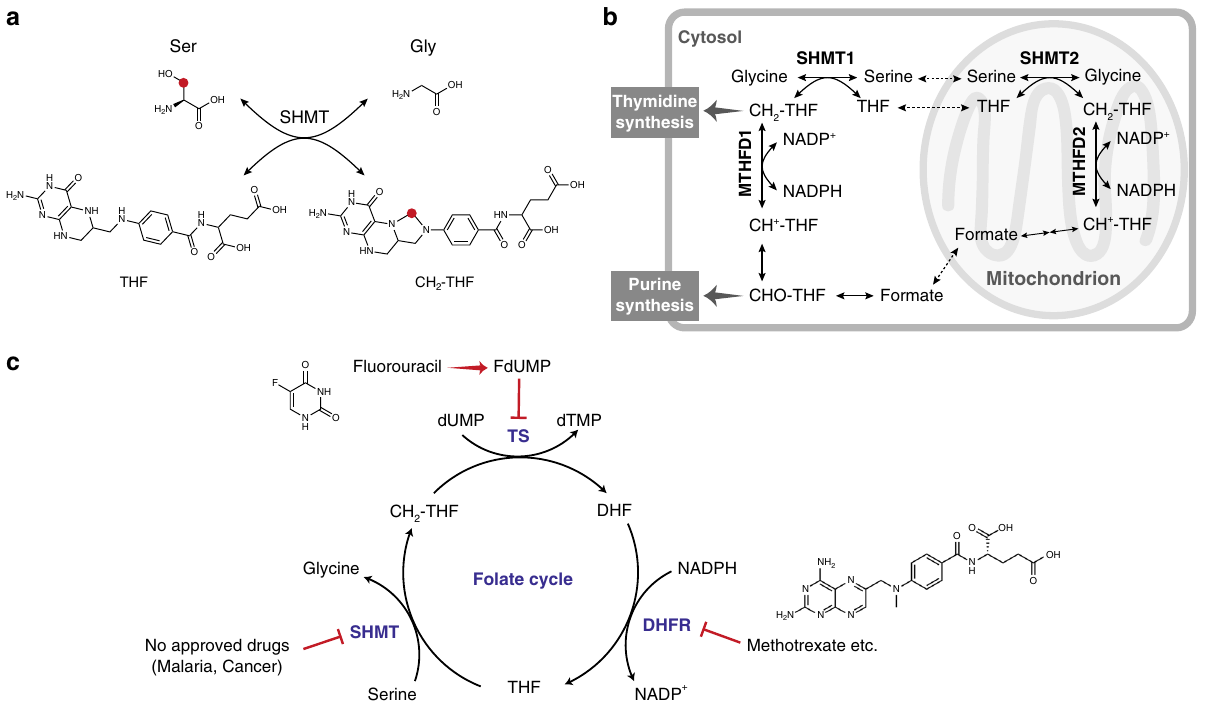
Fig. 1 Biological role of SHMT. a Serine – glycine interconversion catalyzed by SHMT. THF = tetrahydrofolate, CH 2 -THF = N -5, N -10- methylenetetrahydrofolate. The red dot highlights the carbon that is transferred from Ser to THF. b Schematic overview of hSHMT function. MTHFD = methylenetetrahydrofolate dehydrogenase-cyclohydrolase, CH = N -5, N -10-methylenetetrahydrofolate, CH + -THF = 5,10- 2 -THF methenyltetrahydrofolate, CHO-THF = 10-formyltetrahydrofolate, NADP + = Nicotinamide adenine dinucleotide phosphate, NADPH = NADP + reduced form. c SHMT, dihydrofolate reductase (DHFR), and thymidylate synthase (TS) in the folate cycle. THF = tetrahydrofolate, CH 2 -THF = 5,10- methylenetetrahydrofolate, DHF = dihydrofolate, FdUMP = fl uorodeoxyuridine-5 ′ -monophosphate, dUMP = deoxyuridine monophosphate, dTMP = deoxythymidine